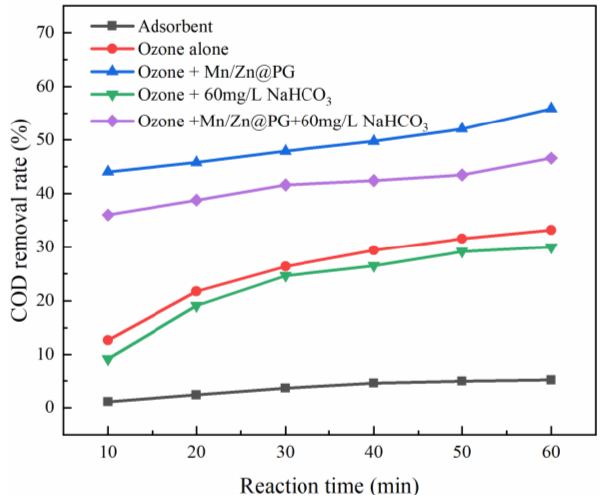
Figure 4. COD removal rates under different reaction systems.